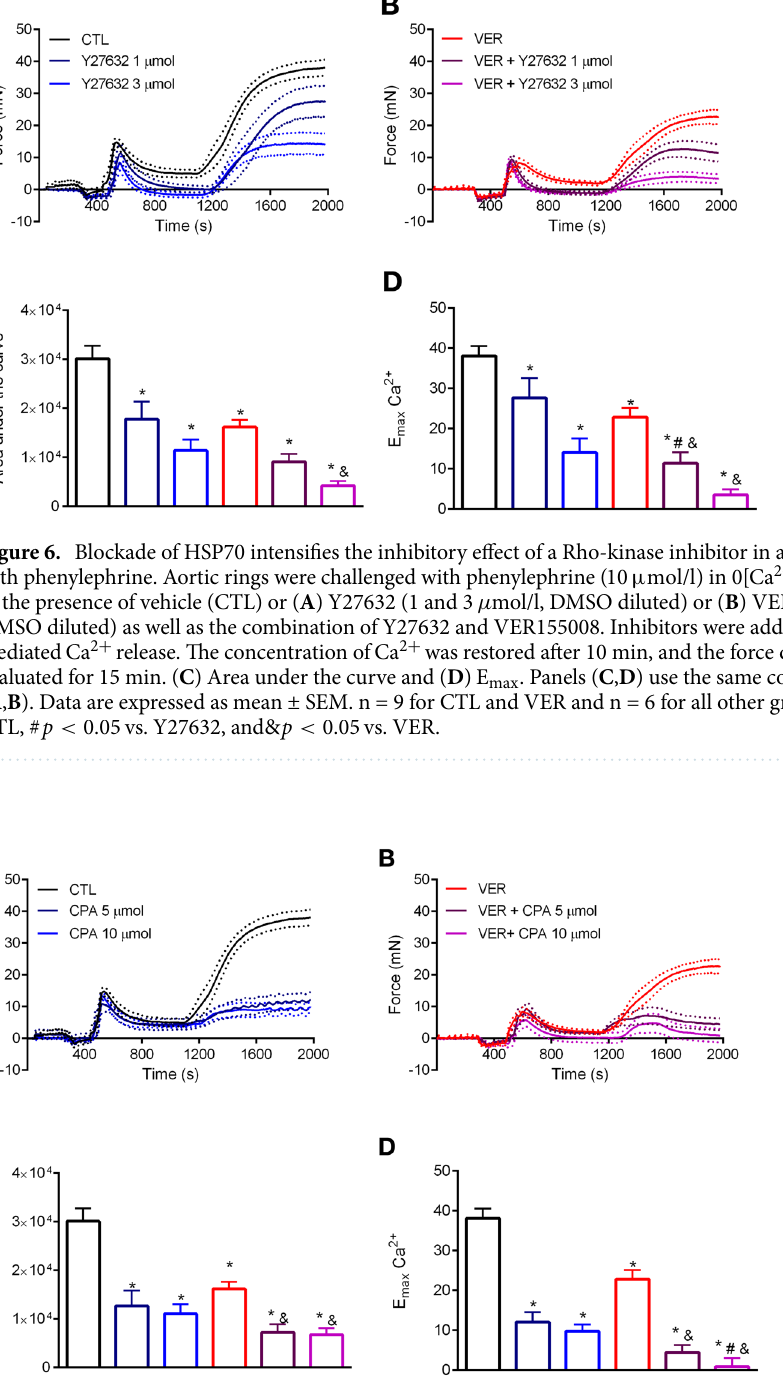
Figure 7. VER155008, an HSP70 inhibitor, further increases the effects of a SERCA pump inhibitor in aorta 2 + stimulated with phenylephrine. Aortic rings were challenged with phenylephrine ( 10 µ mol/l ) in 0[ Ca ] Krebs’ solution in the presence of vehicle (CTL) or ( A ) cyclopiazonic acid (CPA) (5 and 10 µ mol/l , DMSO diluted) or ( B ) VER155008 ( 10 µ mol/l , DMSO diluted) as well as the combination of CPA and VER155008. Inhibitors 2 + 2 + were added before IP3r-mediated Ca release. The concentration of Ca was restored after 10 min, and the force developed was evaluated for 15 min. ( C ) Area under the curve and ( D ) E max . Panels ( C , D ) use the same color scheme as panels ( A , B ). Data are expressed as mean±SEM. n = 9 for CTL and VER and n = 6 for all other groups, * p < 0.05 vs. CTL, # p < 0.05 vs. CPA, and& p < 0.05 vs.